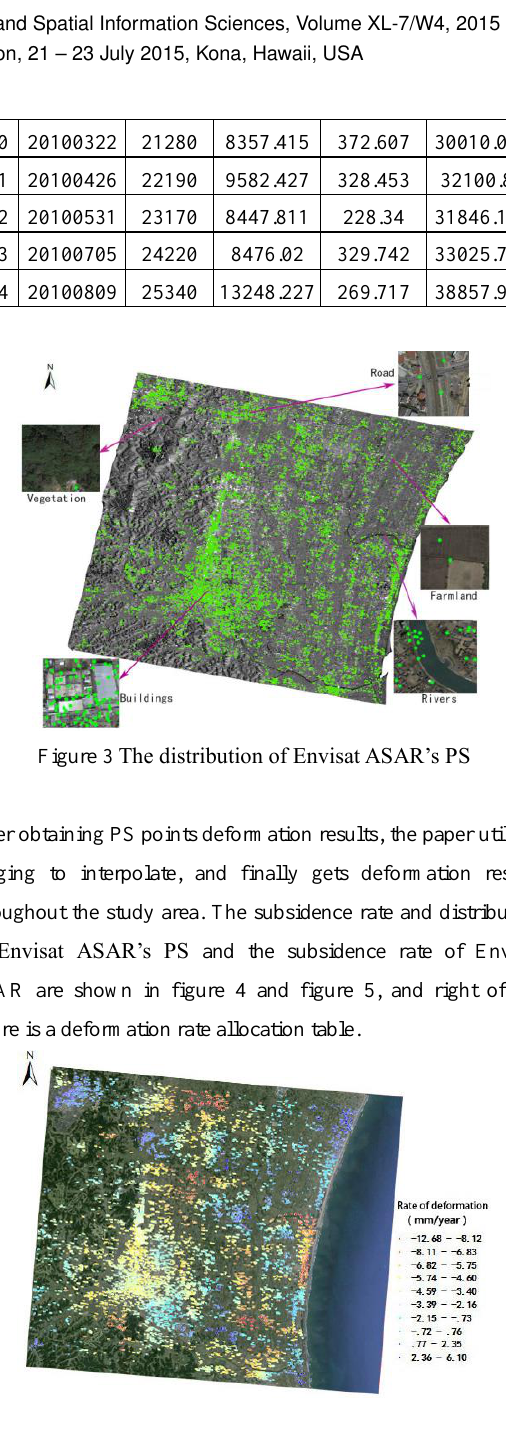
Figure 4 The subsidence rate and distribution of Envisat ASAR’s